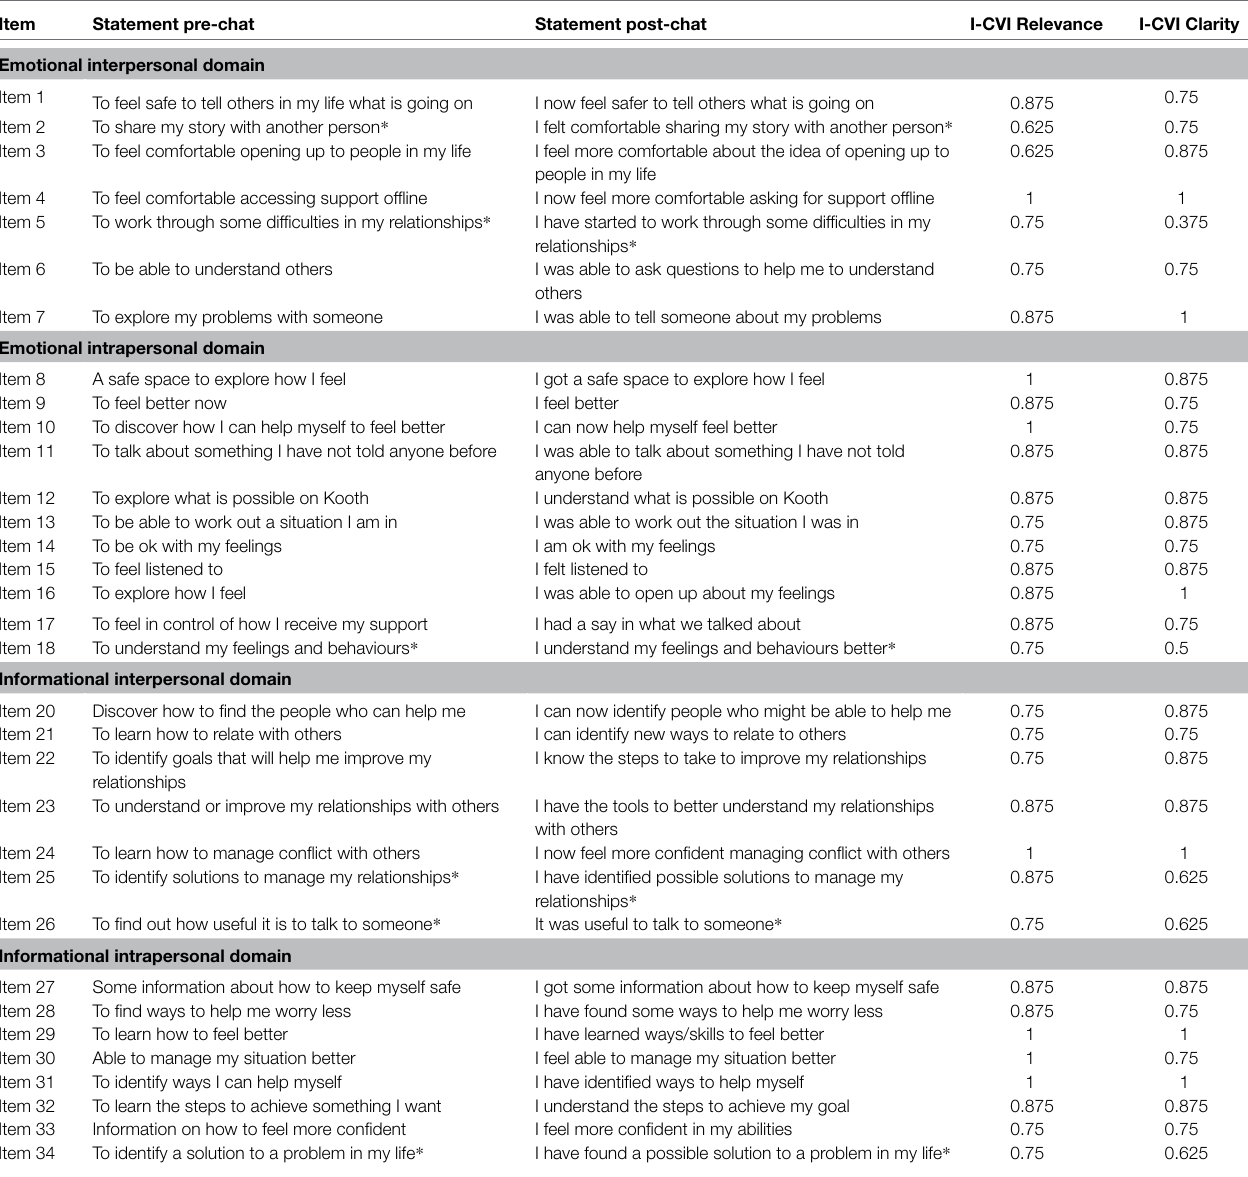
TABLE 1 | I-CVI scores for each item selected from the expert workshops.